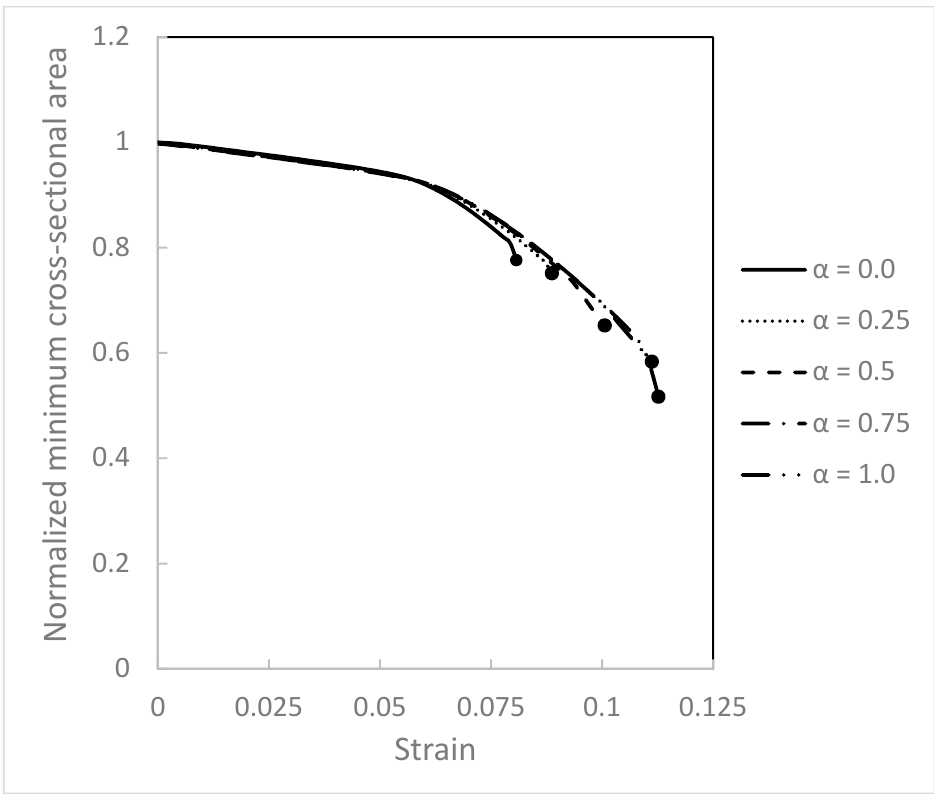
Figure 11. Effect of superimposed hydrostatic pressure on normalized minimum cross-sectional area.